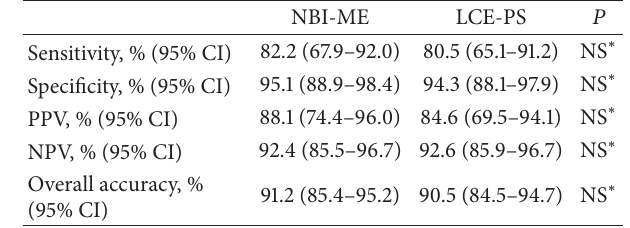
Table 4: Comparison of diagnostic outcomes between NBI-ME and